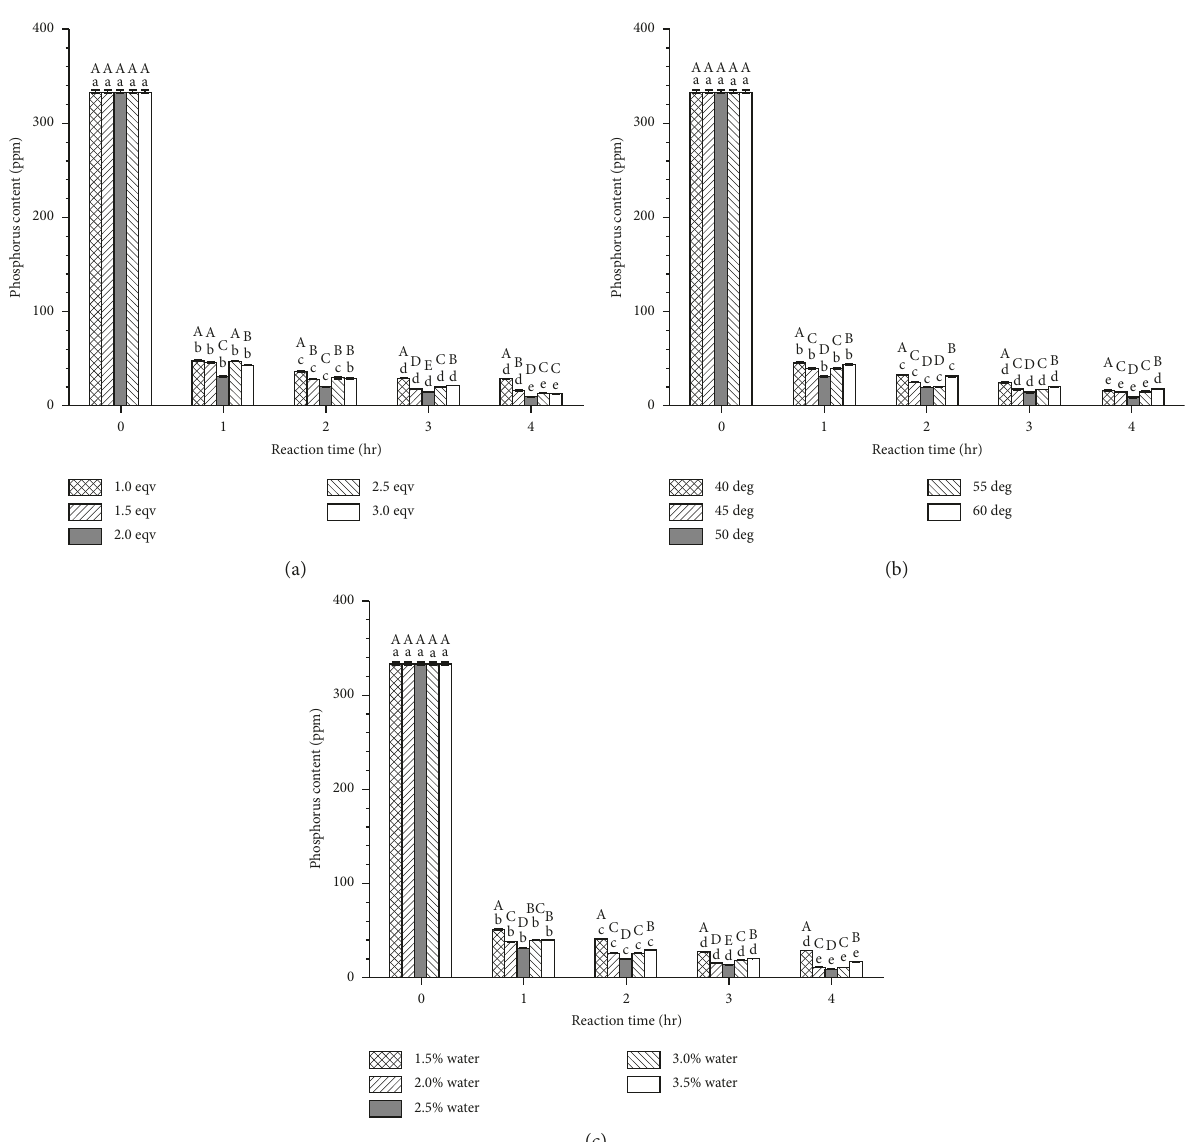
Figure 2: Effect of processing parameters of PLA 1 -catalyzed degumming on P content. Note: uppercase superscripts represent significant differences between groups; lowercase superscripts represent significant differences within a group ( P